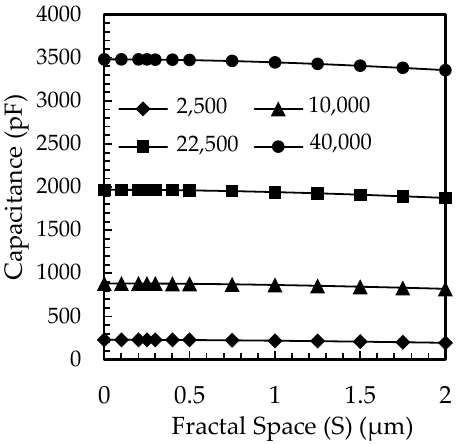
Figure 6. The capacitance of fractal electrode-based FBAR with different fractal space (S) for different active areas (the unit of area in the legend is µ m 2 ).